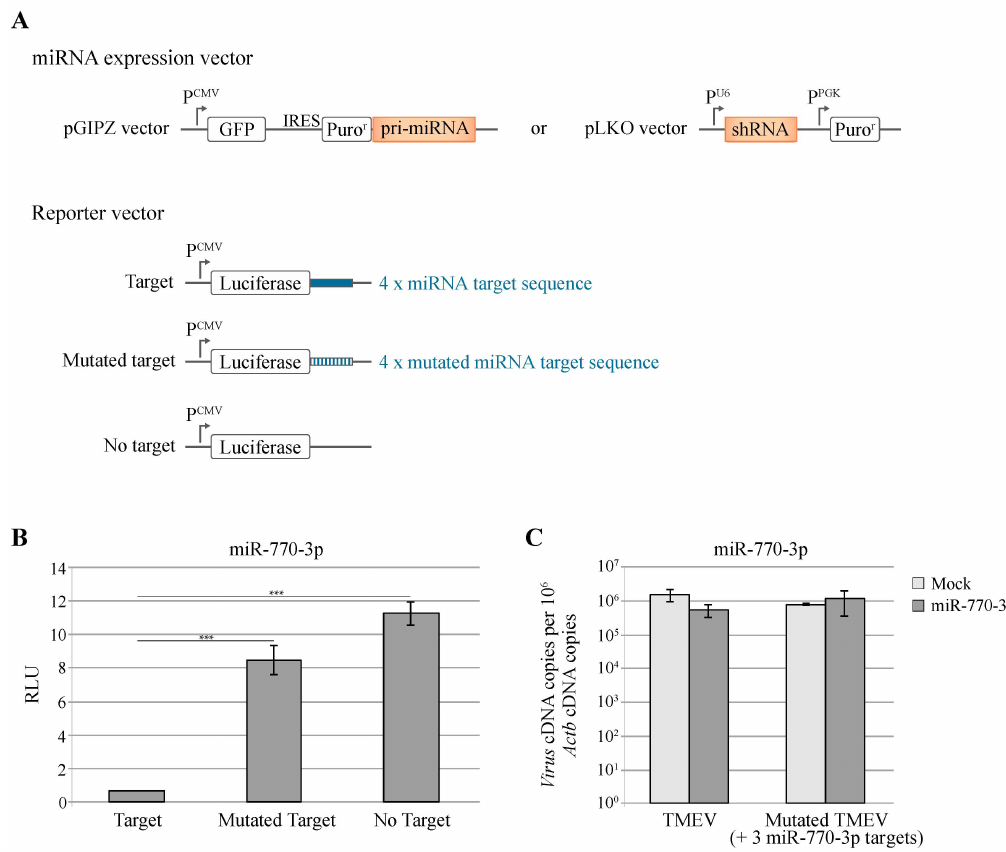
Figure 1. Lack of influence of miR-770-3p on TMEV replication. ( A ) Illustration of miR expression and reporter vectors. miR expression was achieved by expressing either an artificial primary miRNAs using the pGIPZ vector or a short hairpin RNA, using the pLKO.1 vector. Reporter vectors carry a Renilla luciferase gene with 0 (No target) or 4 wild type (Target) or mutated (Mutated target) miR target sequences; ( B ) L929 cells expressing miR-770-3p from the pLKO vector were transduced with the indicated reporter constructs and luciferase activity (Relative Luciferase Units : RLU) was assessed 24 h post transduction; ( C ) L929 cells expressing miR-770-3p were infected for 8 hours with wild type and mutant TMEV derivatives before replication analysis by RT-qPCR ( C ). Viruses were KJ6 (TMEV) and ADC43, a KJ6 derivative carrying 3 extra binding sites for miR-770-3p. Graphs show the mean and SD of a triplicate experiment (out of 2). *** p <